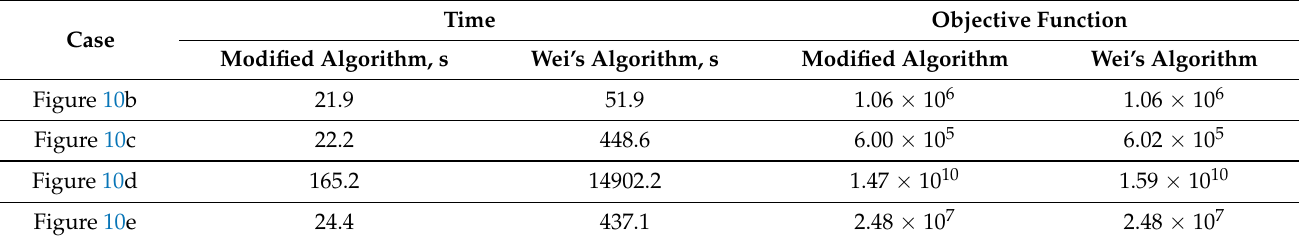
Table 2. Efficiency of algorithms for four